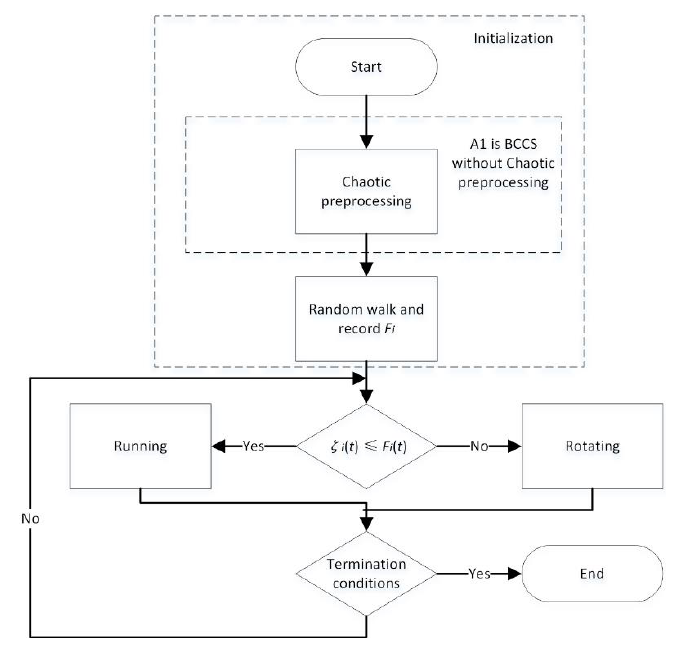
Figure 7. Illustration of the integrated virtual repulsive force for robot i .